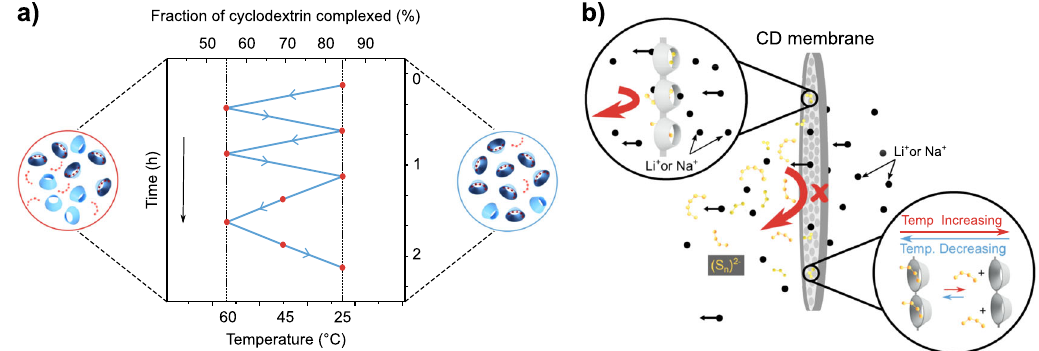
Fig. 6 Temperature-sensitive host-guest interaction between cyclodextrins and polysul fi des. a 1 H NMR temperature cycling experiment (600 MHz, D 2 O, 25 mM NaHCO 3 , pH 10) on α -cyclodextrin (10 mM) in presence of Na 2 S 5 (100 mM). Fraction of α -cyclodextrin complexed, given by the relation of Δ H = Δ H (See “ Methods ” section), is represented as a function of temperature during heating up (60 °C, 55.1 ± 0.1%) and cooling down (25 °C, 84.3 ± 3 3max 0.1%) cycles, where con fi dence intervals are calculated as reported in “ Methods ” section. Because of technical restriction of the NMR probe, we could not go to higher temperature. We expect an almost total dissociation of the complex being achieved increasing the temperature though. b